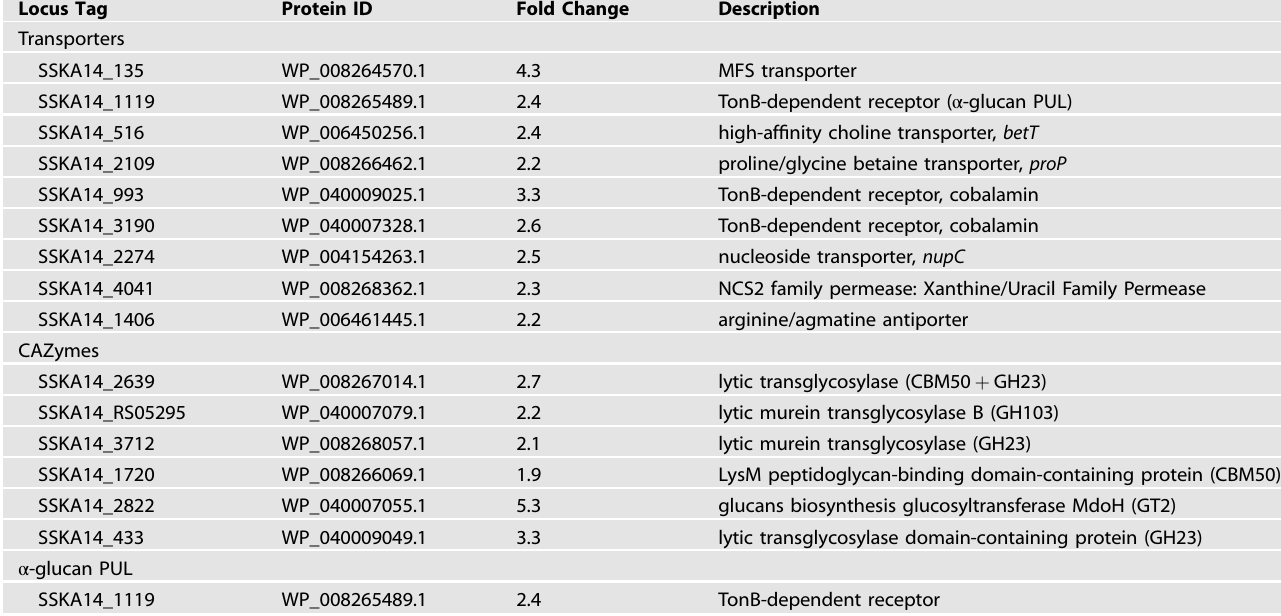
Table 2. Signi fi cantly enriched genes for transporter systems, catabolic enzymes, and carbohydrate-active enzymes in the transcriptome of Stenotrophomonas